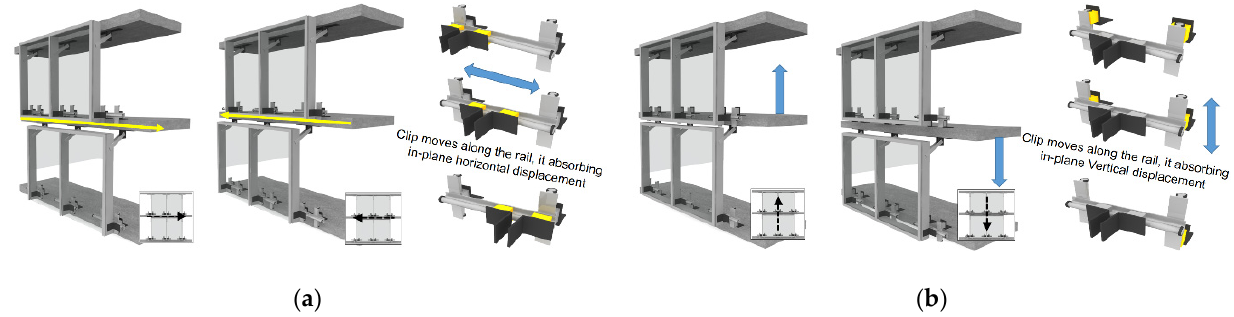
Figure 7. Displacement absorbing principle of seismic fastener: ( a ) X -axis movement; ( b ) Z -axis movement.